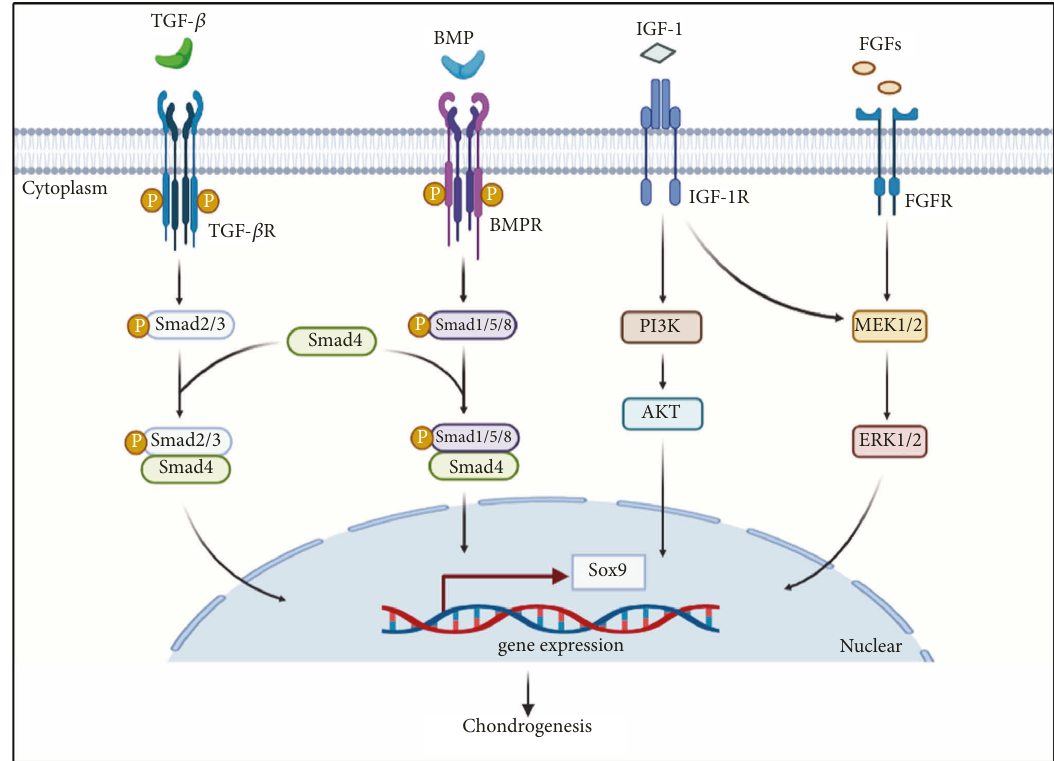
Figure 1: Schematics of representative signaling molecules and associated cartilage regeneration signaling